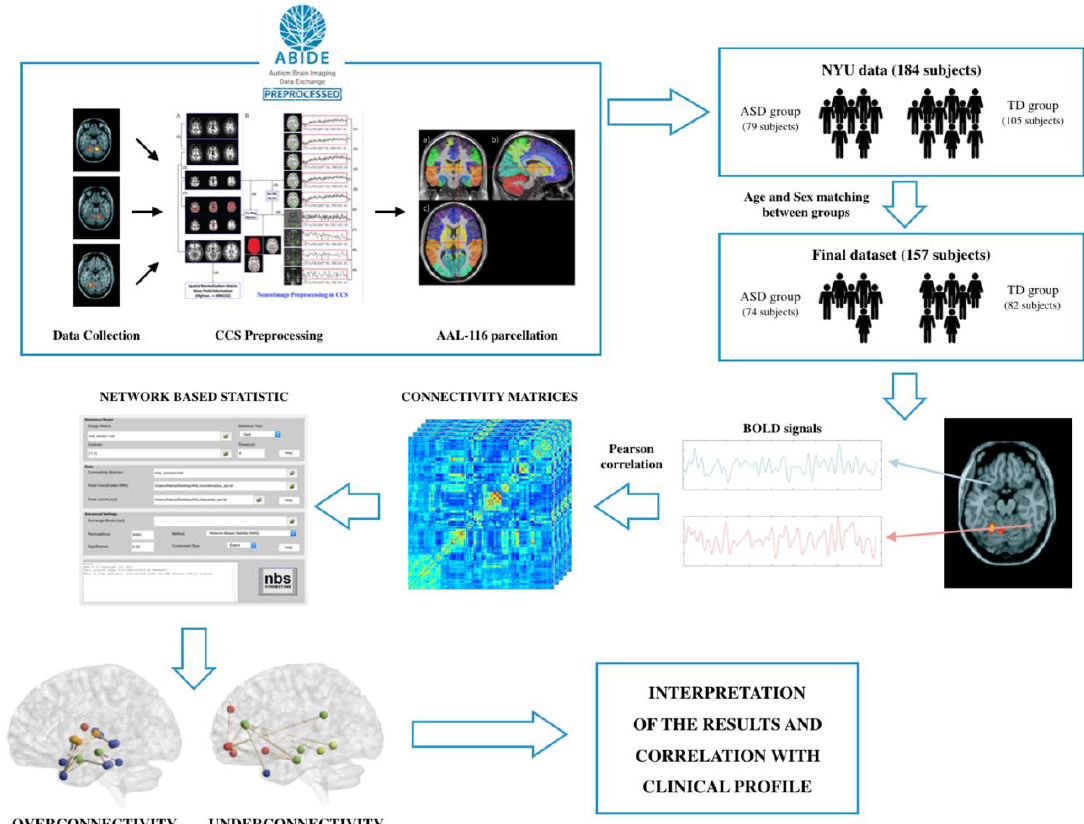
Figure 1. Framework of the study design. Firstly, fMRI images were obtained from ABIDE database (http://fcon_1000.projects.nitrc.org/indi/abide/). Then, ASD and TD groups were age and sex-matched, and functional brain networks were obtained using Pearson’s correlation coefficient between BOLD signals of every pair of brain regions. Using the toolbox “Network Based Statistic Toolbox” for Matlab, these networks were analyzed.